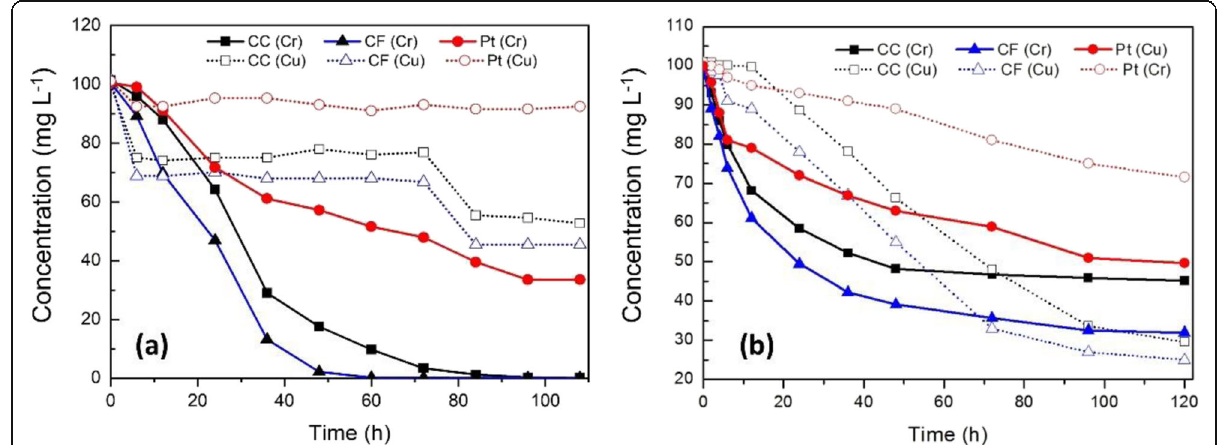
Fig. 6 dcESM behavior Cu 2+ on CC, CF, and Pt: a at pH 2; b at pH